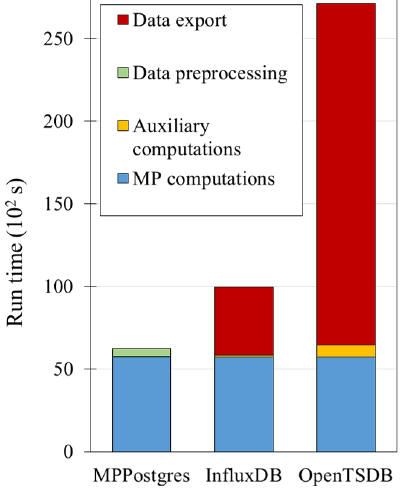
Figure 16. Performance of different TSDBMSs in the electricity theft detection